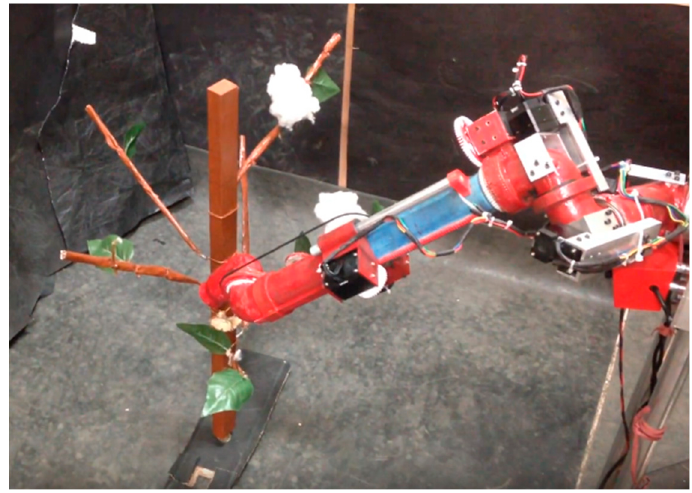
Figure 10. Old design of Green Robot Machinery (gRoboMac) manipulator trying to get the cotton boll (source: thetechpanda.com).